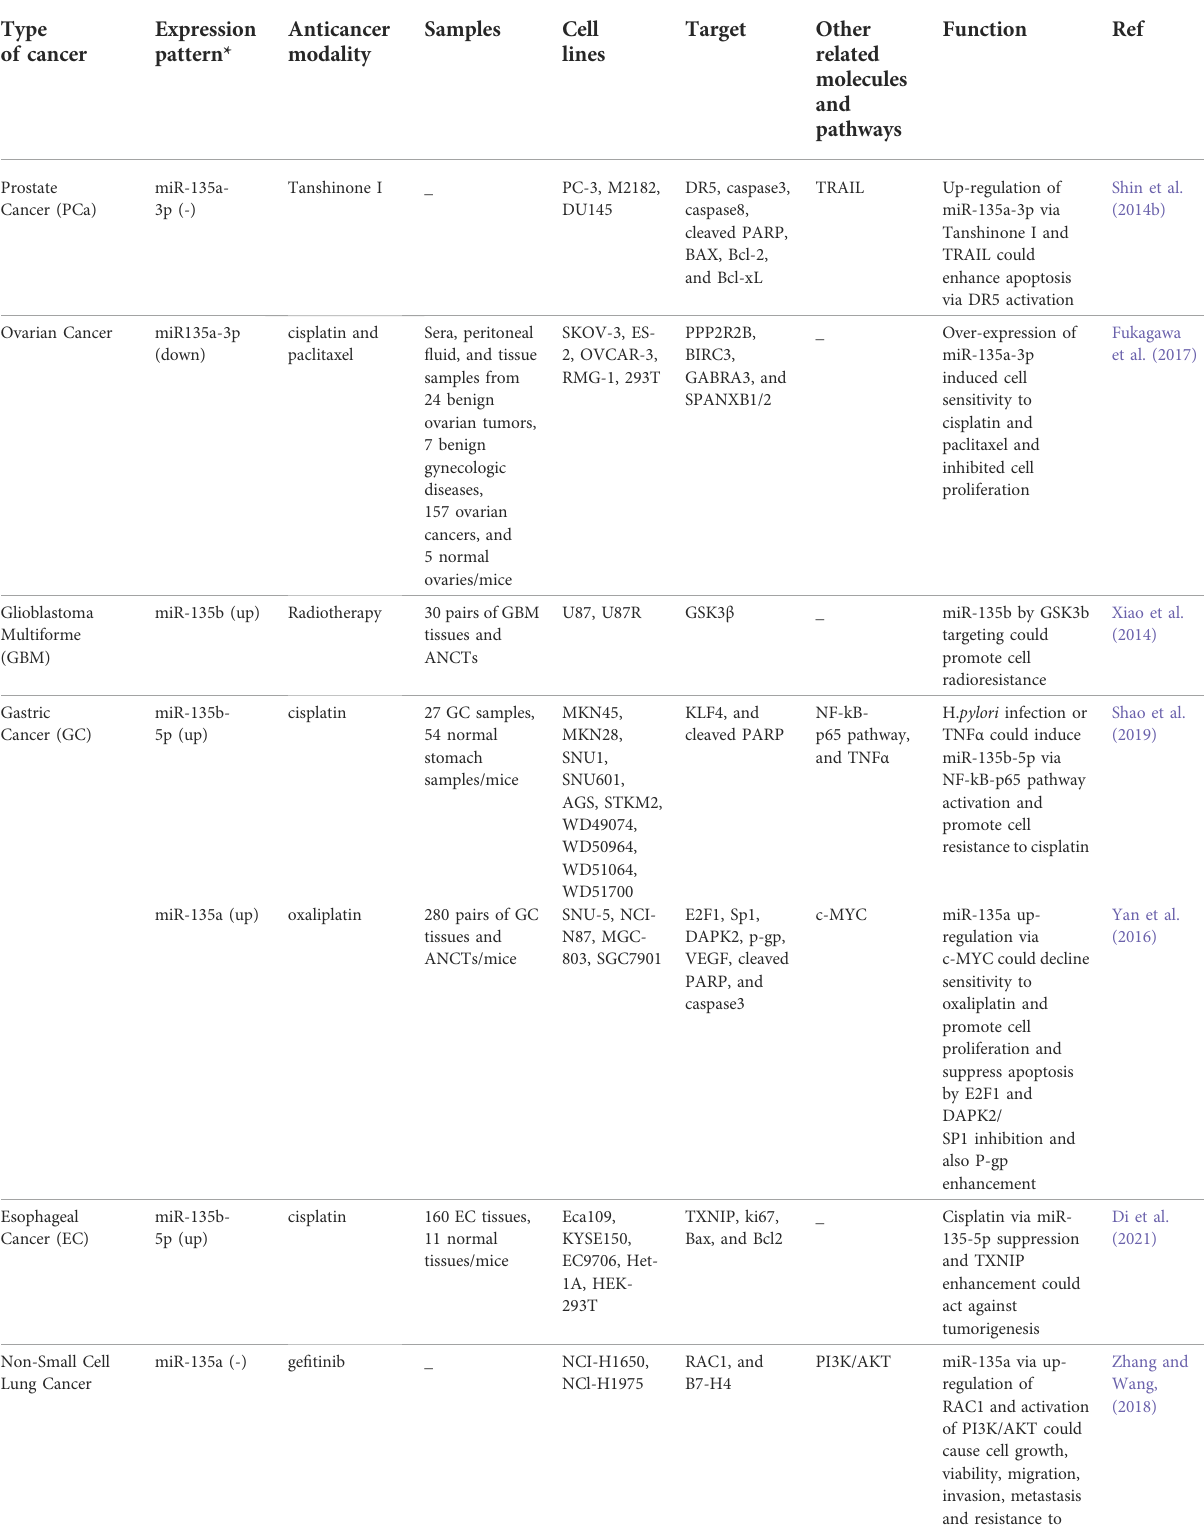
TABLE 1 Effect of miR-135 in the response to chemotherapy, radiotherapy and other therapeutic